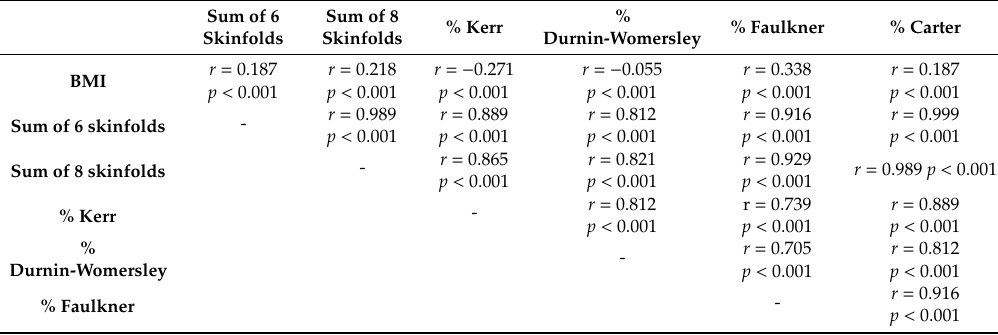
Table 5. Correlation between BMI, sums of skinfolds and fat mass